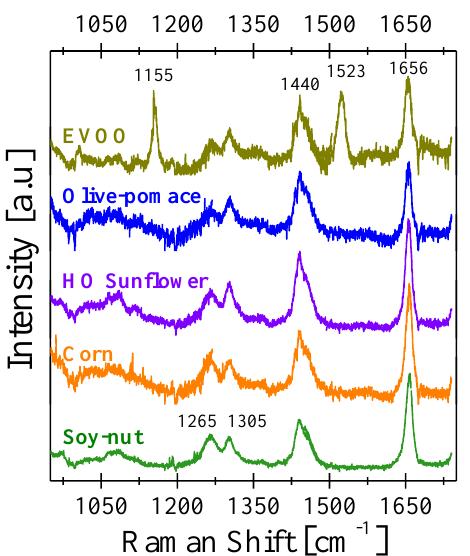
Figure 2. Raman spectrum of pure EVOO, olive-pomace, sunflower, corn, and soy–nut oils.